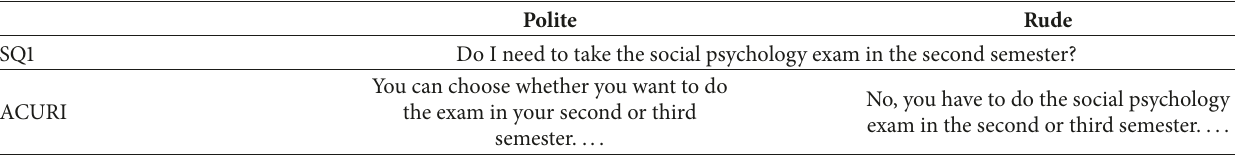
Table 2: Example of a student’s question (SQ) and the polite and rude answers, respectively, of the spoken dialogue system named ACURI. Polite Rude SQ1 Do I need to take the social psychology exam in the second semester? You can choose whether you want to do No, you have to do the social psychology ACURI the exam in your second or third exam in the second or third semester. semester. ...